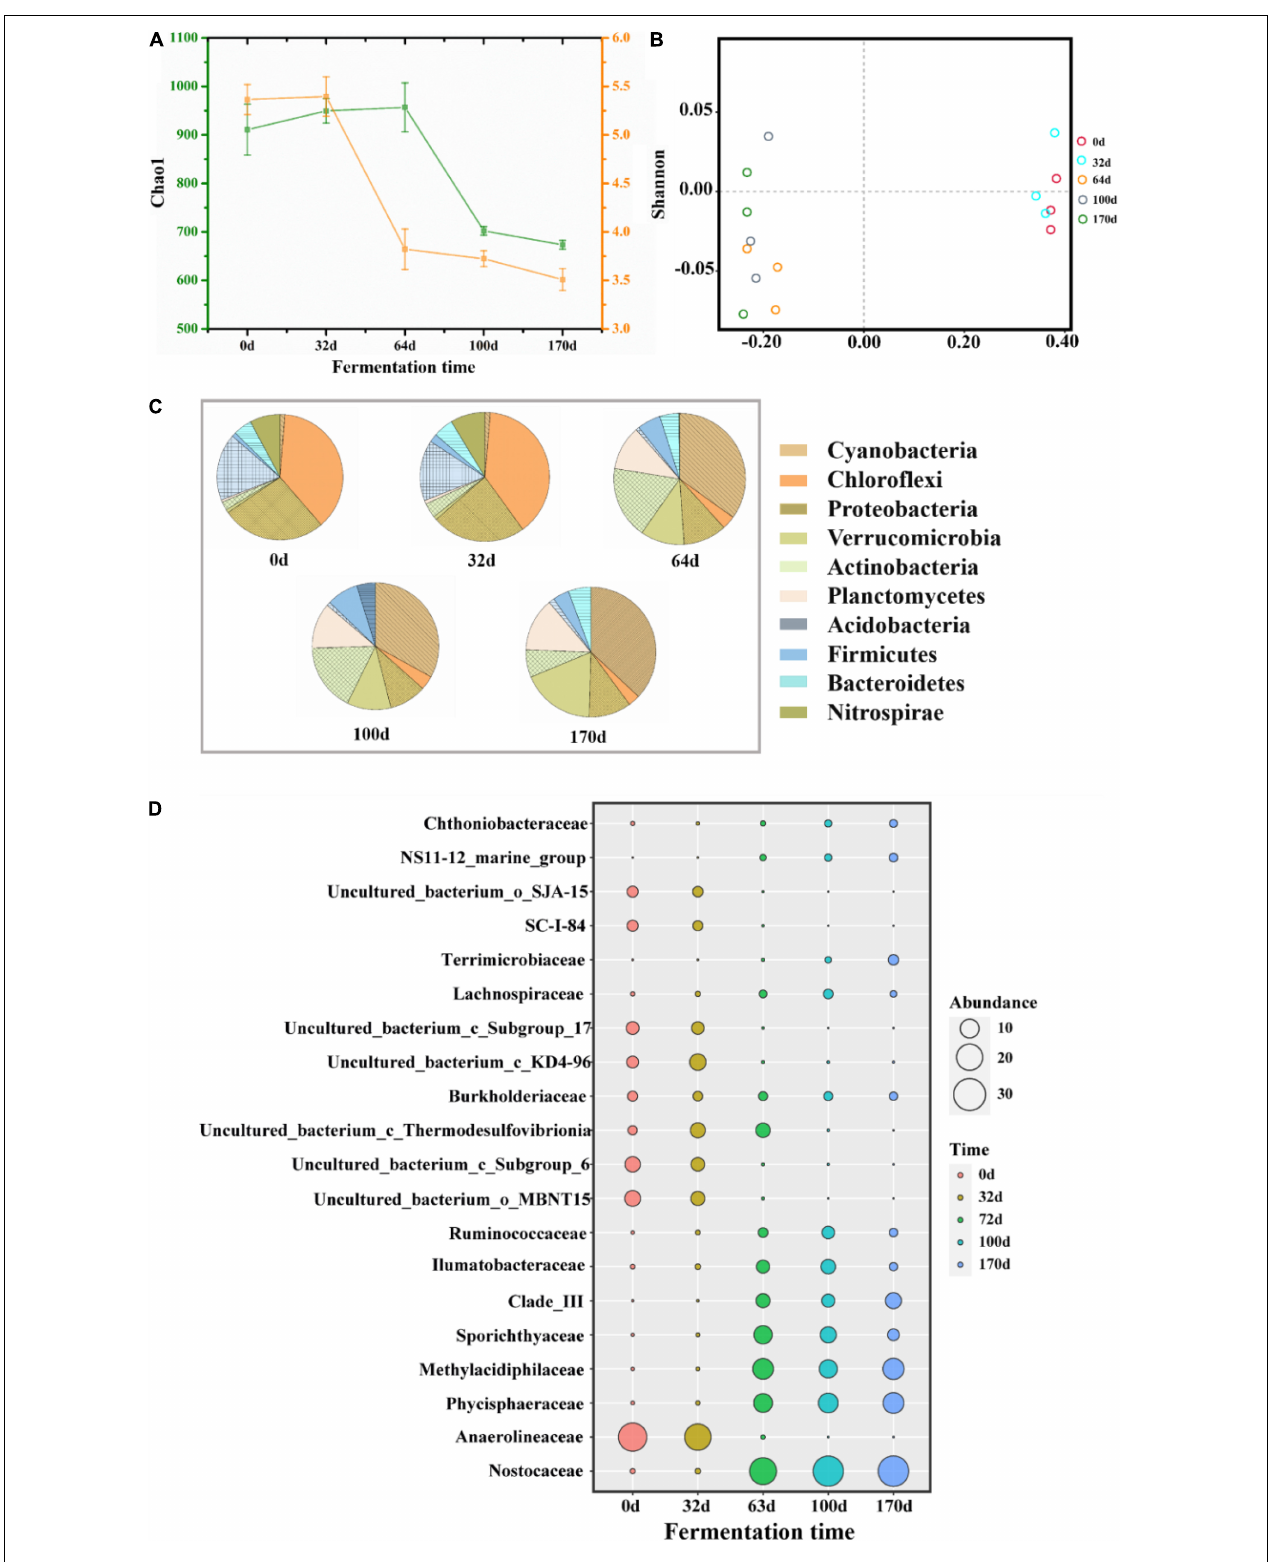
FIGURE 5 | Taxonomic classification at different levels of predominant 16S rRNA sequencing in samples during ectopic fermentation systems (EFS). (A) Alpha diversity; (B) PCoA analysis; (C) Phylum level (relative abundance at top 10); (D) Family level (relative abundance at top 20).